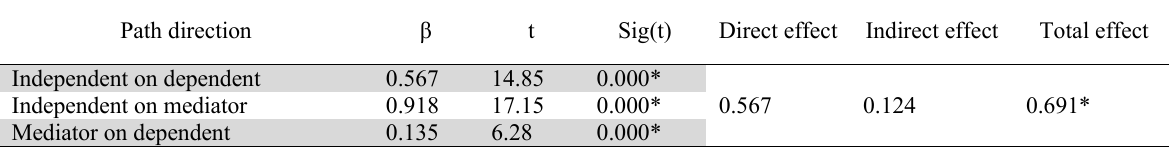
Path analysis for testing the mediation effect of branded pharmacy on the direct relationship between the independent and the dependent variables